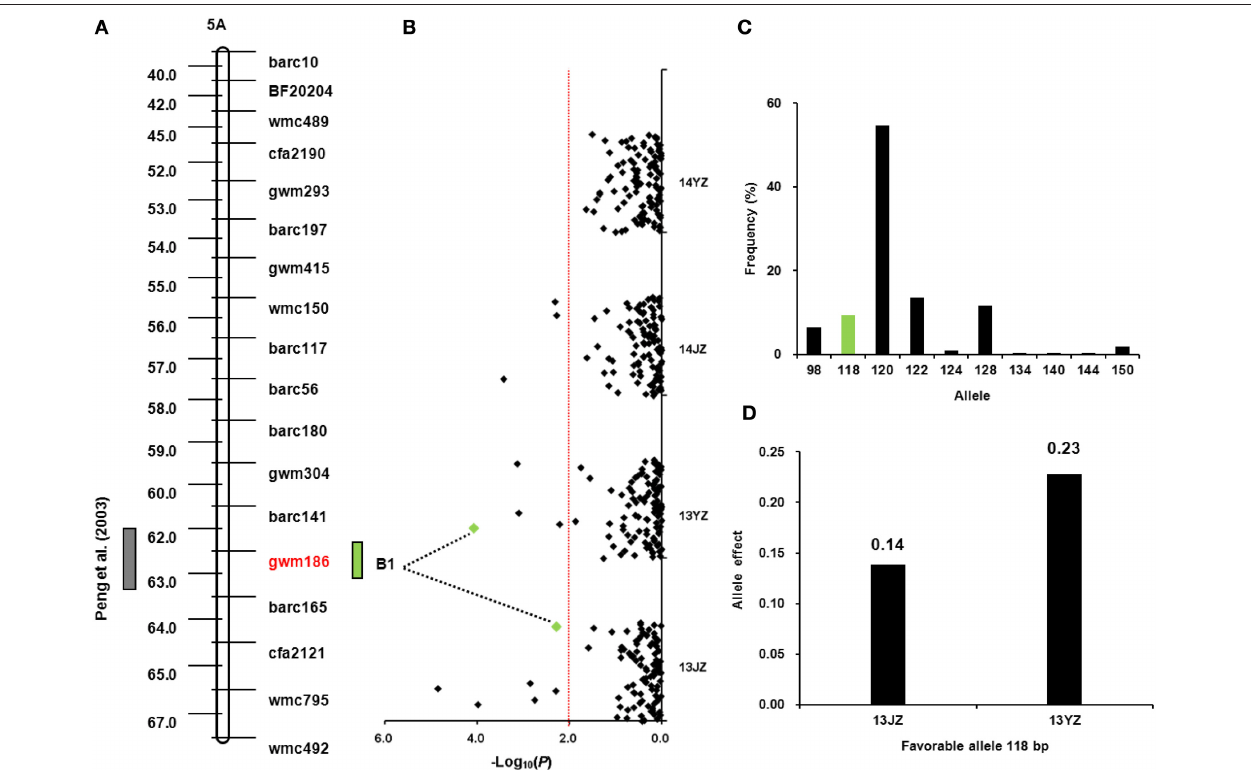
FIGURE 3 | Favorable allele of Xgwm186 and genetic effect on grain-setting in the basal spikelets. (A) QTL locus at Xgwm186-5AL (Peng et al., 2003); (B) Association signals in the natural population using a mixed linear model ( P < 0.01 ); green dots represents the associated signal of Xgwm186 in different environments; (C) Frequency distribution of Xgwm186-5A alleles in the population; green bar represents favorable allele of 118 bp; (D) Genetic effects of Xgwm186-5A 118 in environments 13JZ and 13YZ.